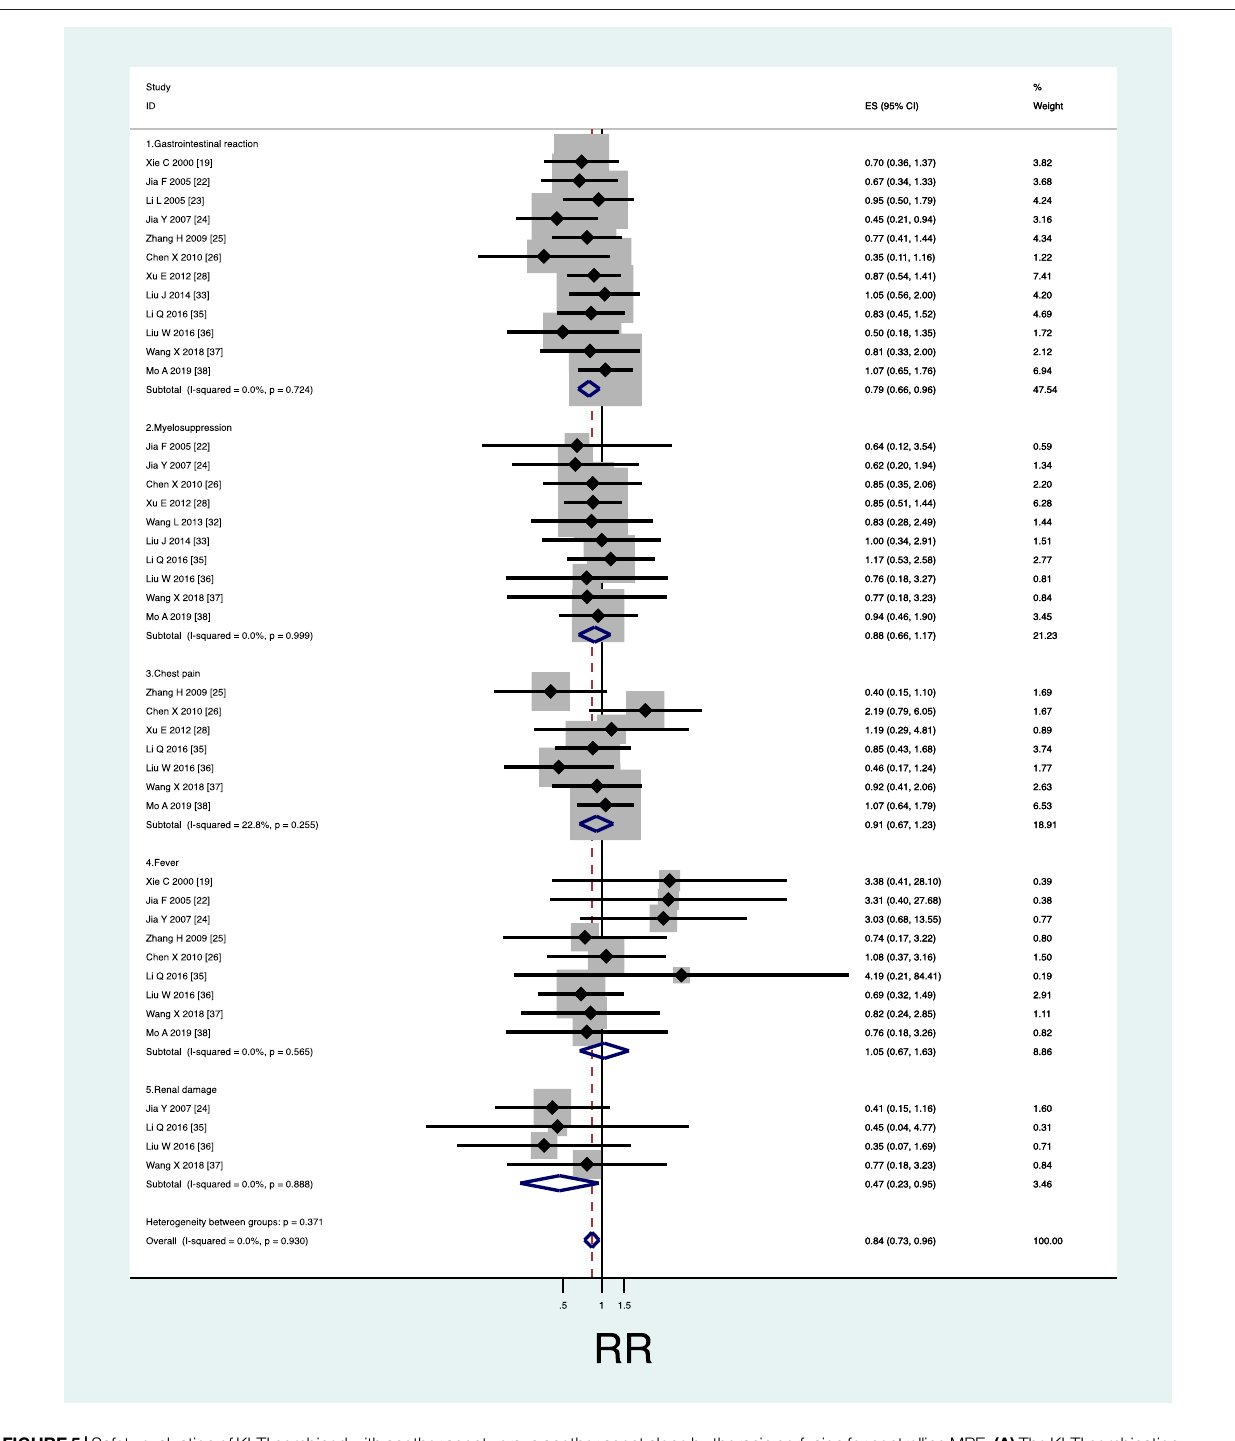
Frontiers in Pharmacology |